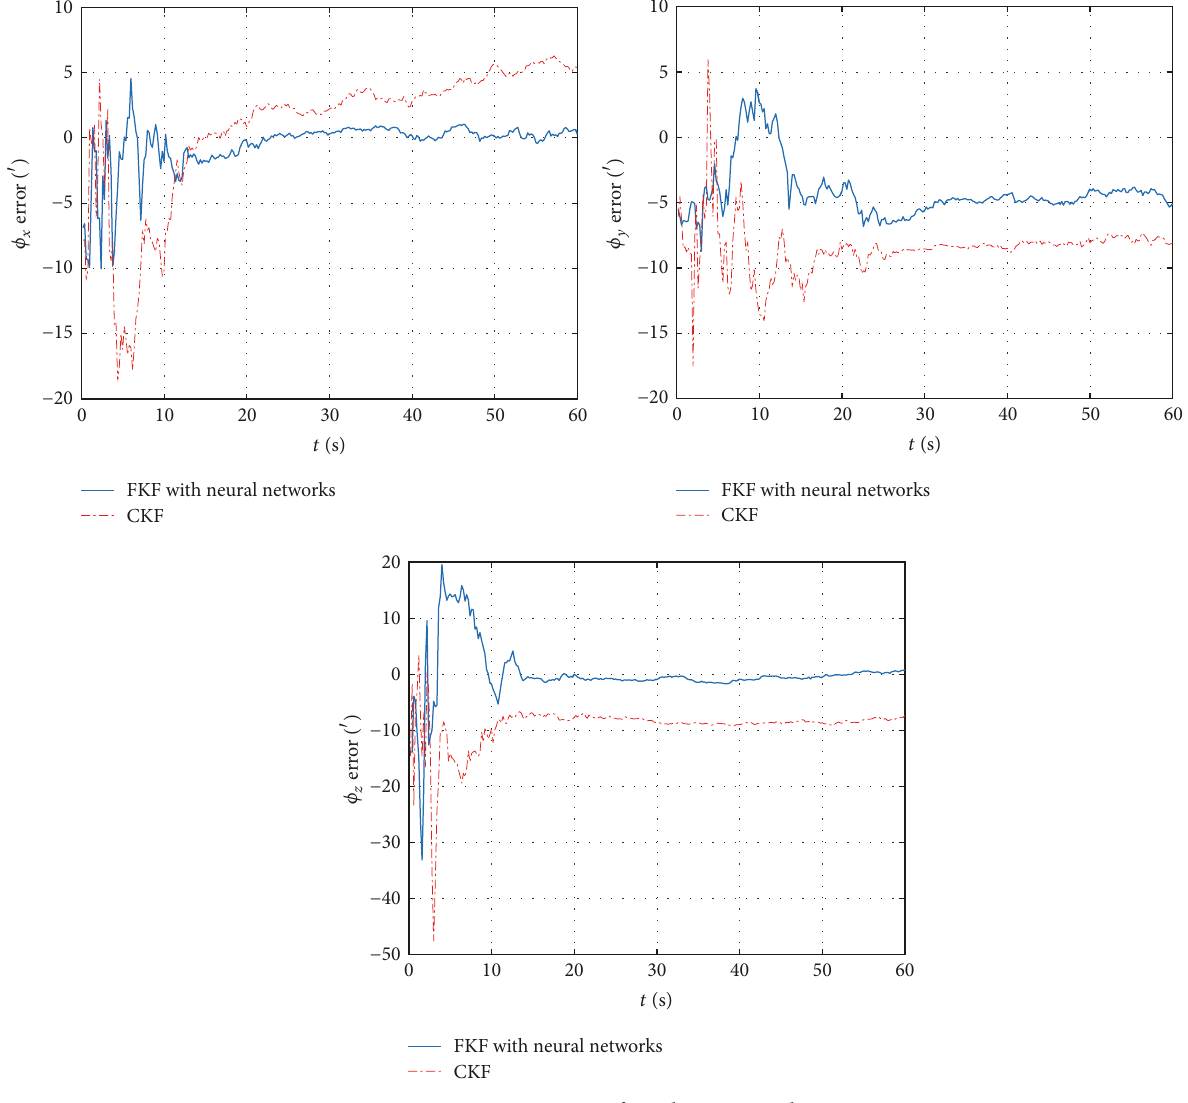
Figure 5: Estimate error of misalignment